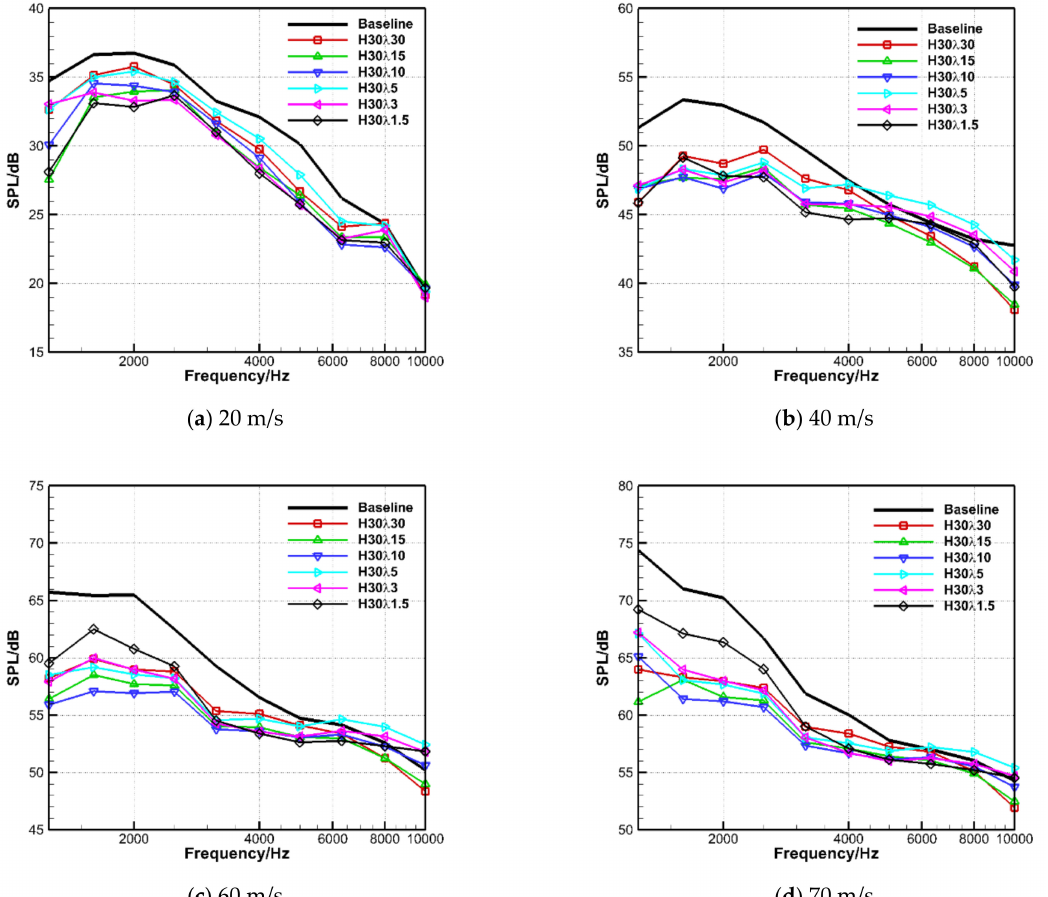
Figure 14. Spectra of the TE noise with different sawtooth wavelengths (H = 30